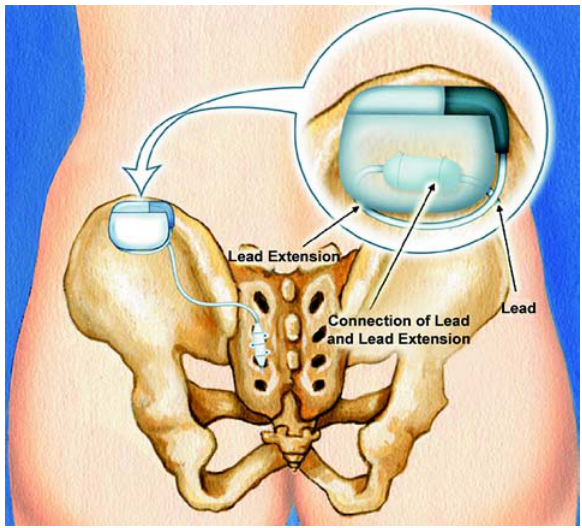
Figure 6 – Stage II sacral neuromodulation- Implantable pulse generator (IPG) unit is placed in the subcutaneous pocket.